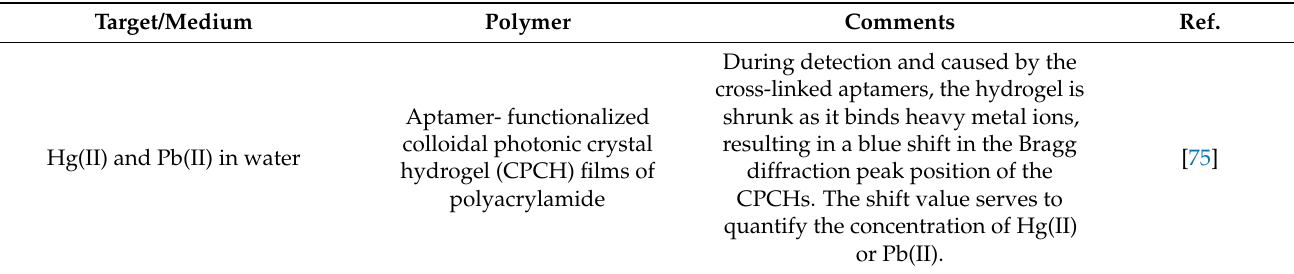
Table 2. Classification of the most relevant works of the last ten years for the detection of heavy metals with sensory polymers, identifying the target, the medium, the type of polymer, and the interaction/response